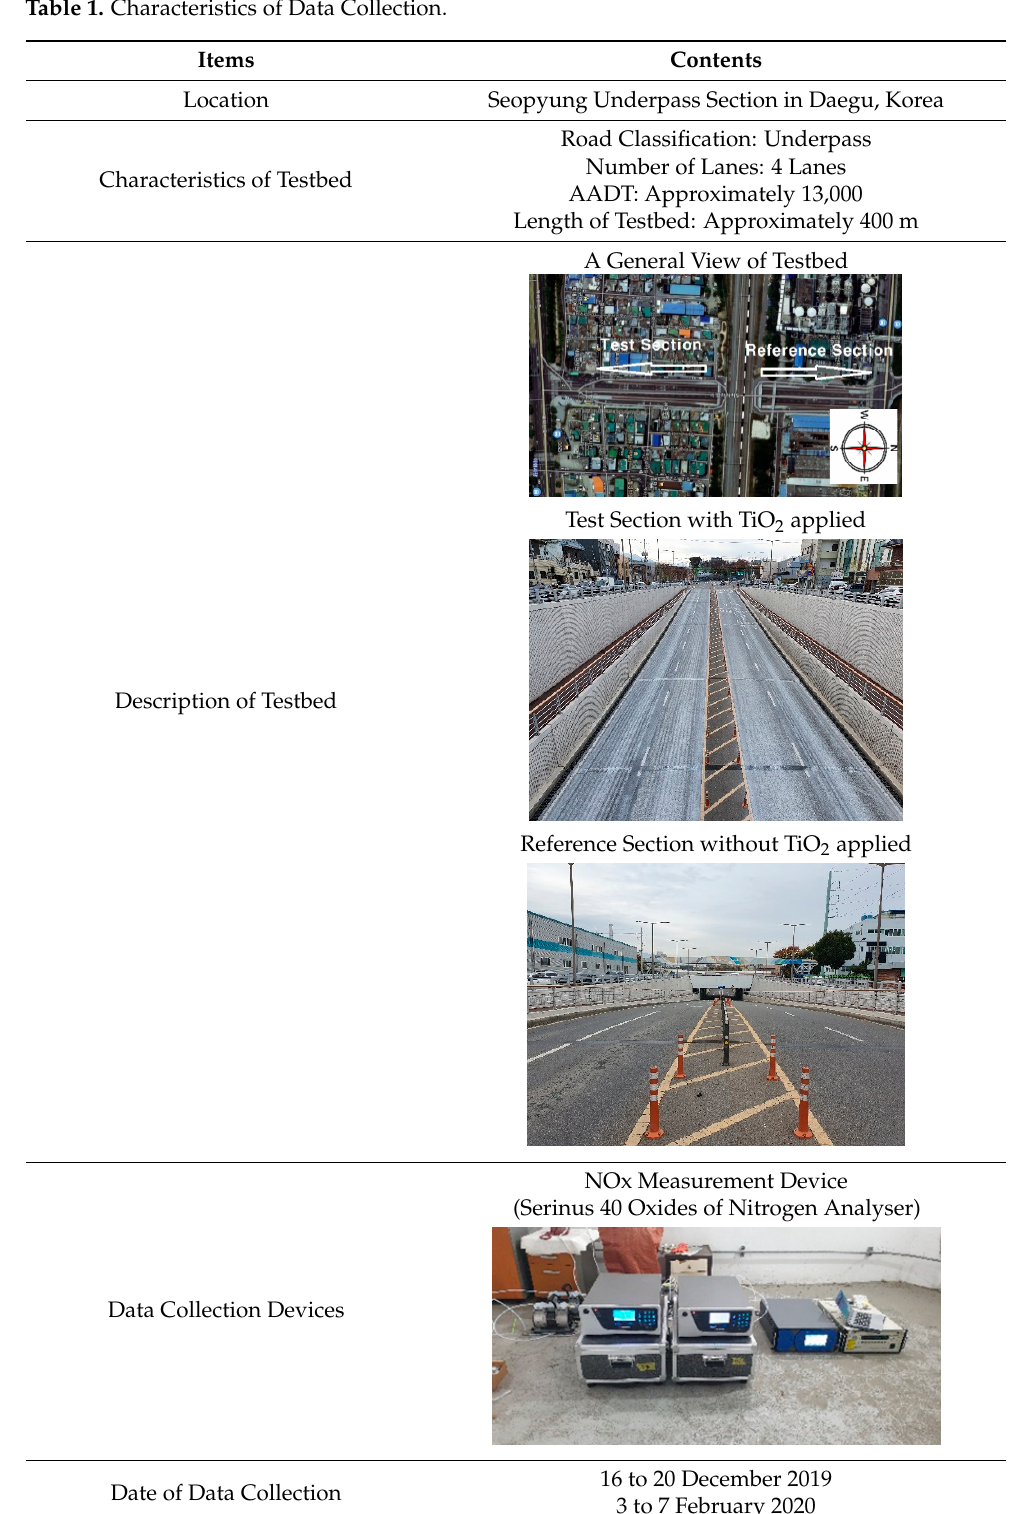
Table 2. Weather Information of Measurement Days.